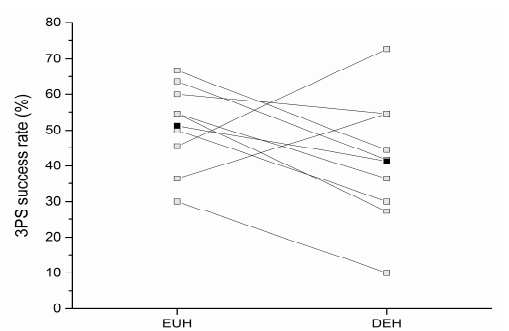
Figure 2. Mean ( black dots ) and individual ( white dots ) 3PS success rate in the EUH and DEH conditions.